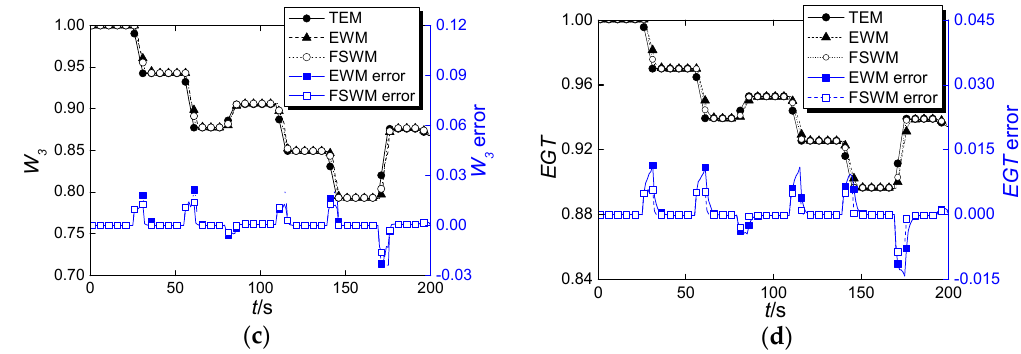
Figure 8. Variations of aircraft engine model outputs in joint test: ( a ) NL ; ( b ) NH ; ( c ) W 3 ; ( d ) EGT .